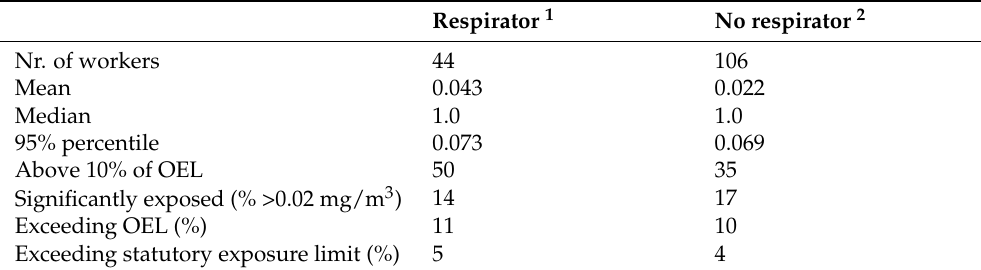
Table 5. Respirable quartz exposure of workers in relation to respirator use. Respirator 1 No respirator